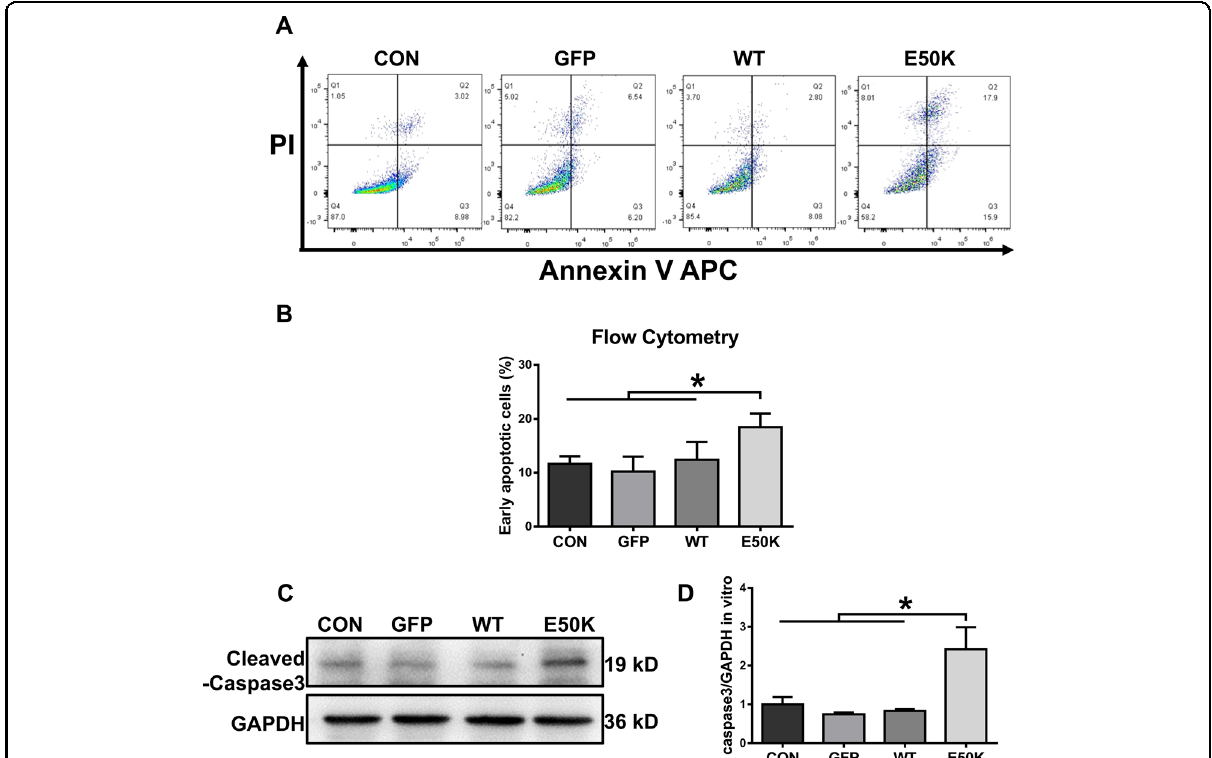
Fig. 3 Effects of OPTN-E50K overexpression on the apoptosis of transgenic R28 cells. A The apoptosis rates were measured via fl ow cytometry and B quanti fi cation of early apoptotic cells 48 hours after transfection. GFP-positive cells were counted in the GFP, WT and E50K groups. PI propidium iodide. n = 3. C Representative western blot image and D quanti fi cation of cleaved caspase-3 protein expression in transfected cells. n = 4. Mean ± SEM. * P < 0.05.